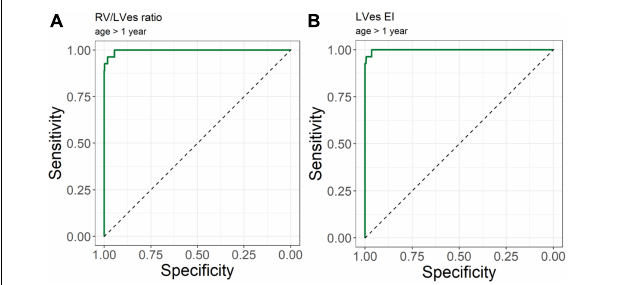
FIGURE 6 | Receiver operating curve (ROC) analysis for the detection of pulmonary hypertension patients. Using (A) RV/LVes Ratio (AUC = area under the curve: 0.997, 95%CI: 0.993–1.000) and (B) LVes EI (AUC: 0.999, 95% CI: 0.996–1.000) in children older 1